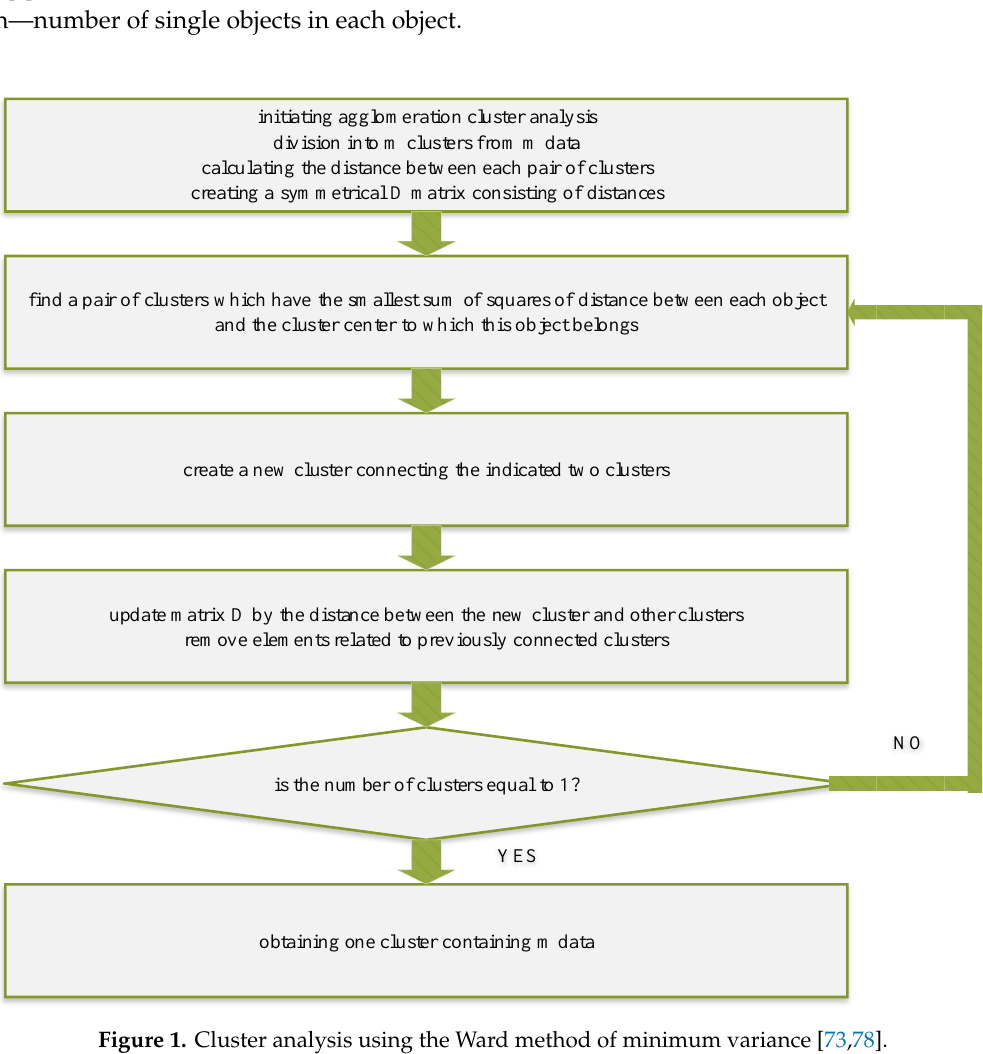
Figure 1. Cluster analysis using the Ward method of minimum variance [73,78].